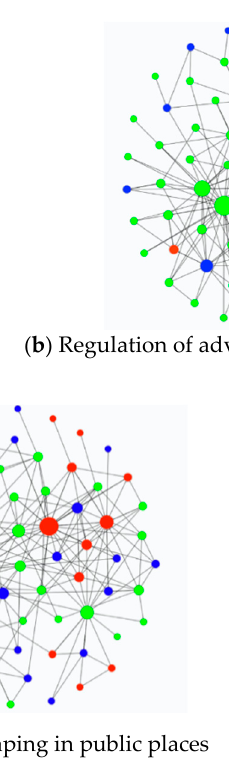
Figure 3. Network diagrams illustrating the position of health-focused actors on proposed policies, sized according to degree centrality. Colour-coding represents health-focused actors’ positions on each policy: green = supportive, red = not supportive, blue = unclear or missing